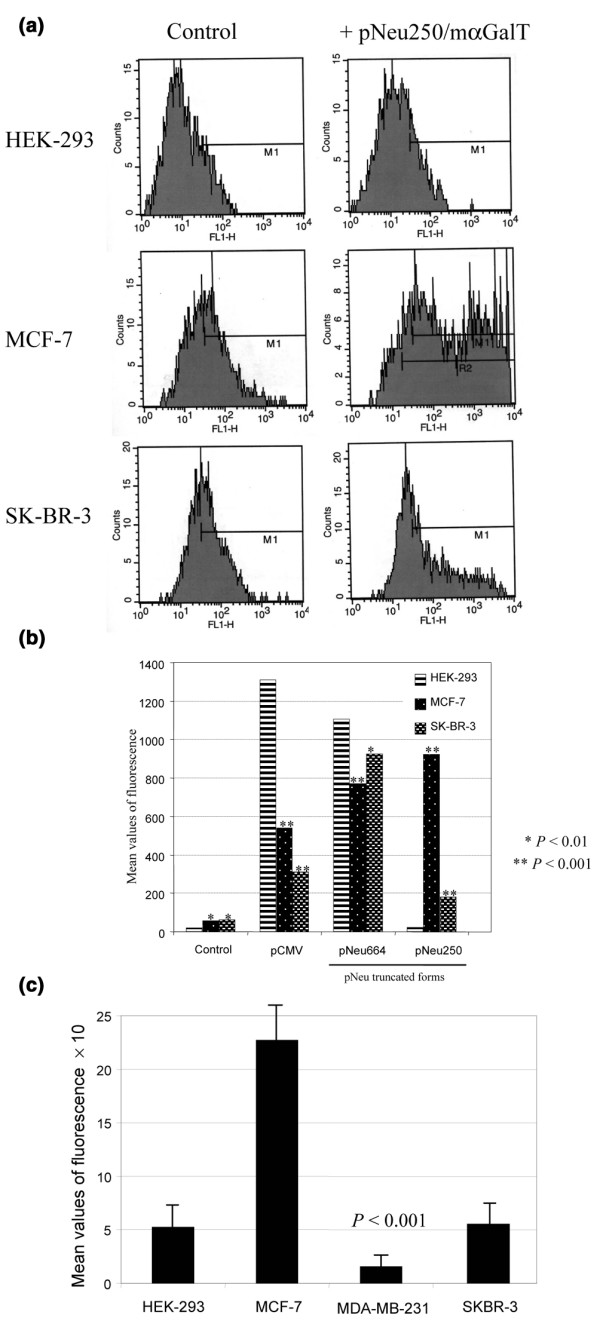
Expression of Galα1,3Gal residues at the surface of transduced cells. Cells stably transduced or not with CMV promoter (pCMV)/murine α1,3galactosyltransferase (mαGalT), pNeu664/mαGalT, or pNeu250/mαGalT were labeled with fluorescein isothiocyanate-conjugated Griffonia simplicifolia/isolectin B4 (FITC-GS-I-B4) lectin (Galα1,3Gal) and analyzed on a FACScan cytometer (counts, cells numbers; FL1-H, fluorescence intensity). (a) Binding of FITC-GS-I-B4 to parental and pNeu250/mαGalT transduced HEK-293, MCF-7 and SK-BR-3 cells. Mean values of fluorescence detected by flow cytometry at the surface of stably transduced cells with (b) the constructs pNeu664/mαGalT or pNeu250/mαGalT in a plasmid vector (experiments in triplicates), and (c) the construct pNeu250/mαGalT in a self-inactivating retroviral vector (experiments were conducted using four to five subclones).